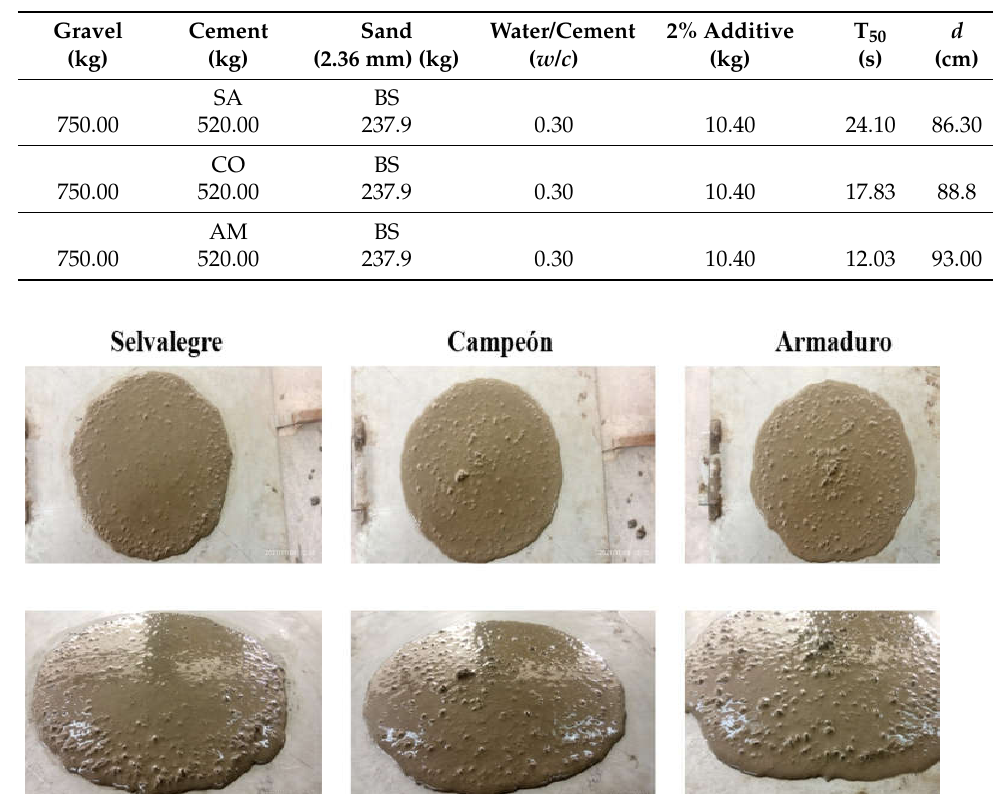
Figure 9. Results of the Abrams cone corresponding to the three SCCVPC inferred from the corre- sponding F3-CEMs (BS sand, / = 0.30 , 2.0 %cw Viscocrete additive).